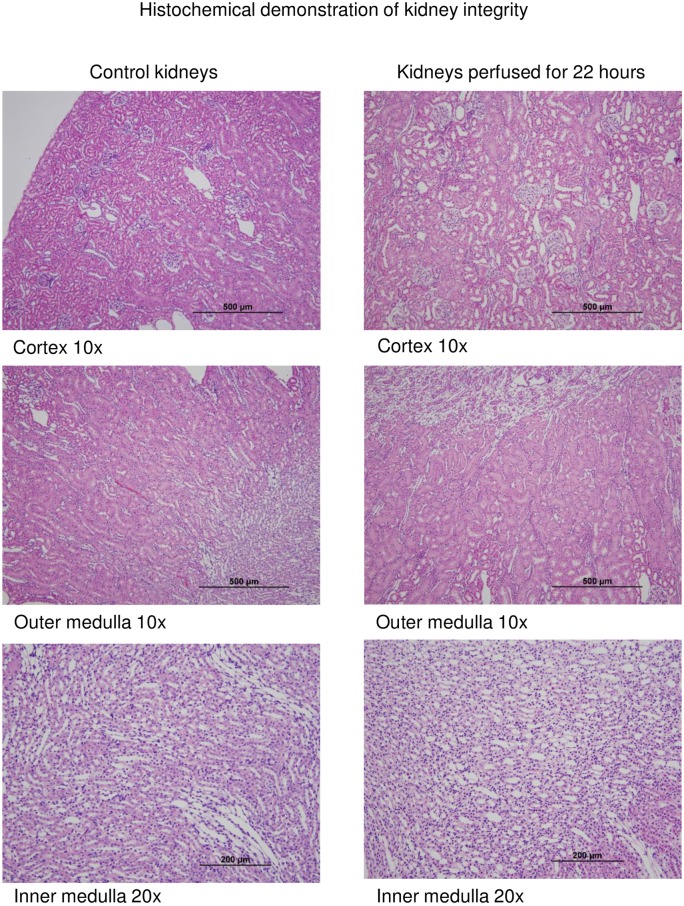
Light microscopy (H&E stain) of representative rat kidney at initial flush and after 22 hours of machine cold perfusion (n = 5 per time point).